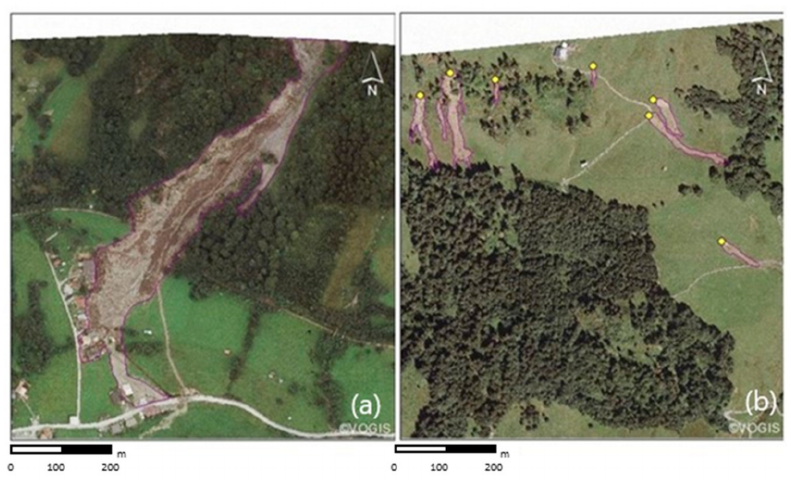
Figure 5. Close-up view of the destructive large Danöfen earth flow ( a ) and of a group of six small landslides (highlighted with purple polygons) in the area of Hintereggalpe ( b ) almost simultaneously activated in August 2005 (aerial-photos© VoGIS).